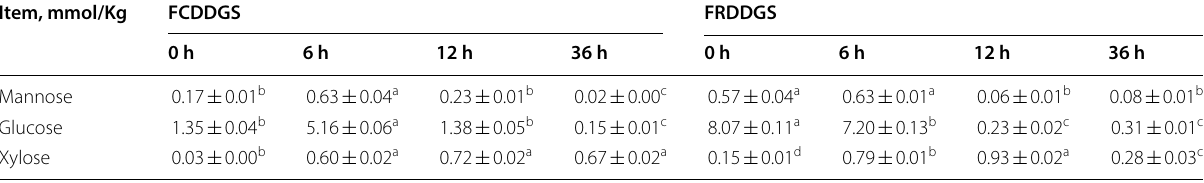
Values are means of three replicates per treatment. Means in a row without common superscript differ significantly ( P < 0.05)